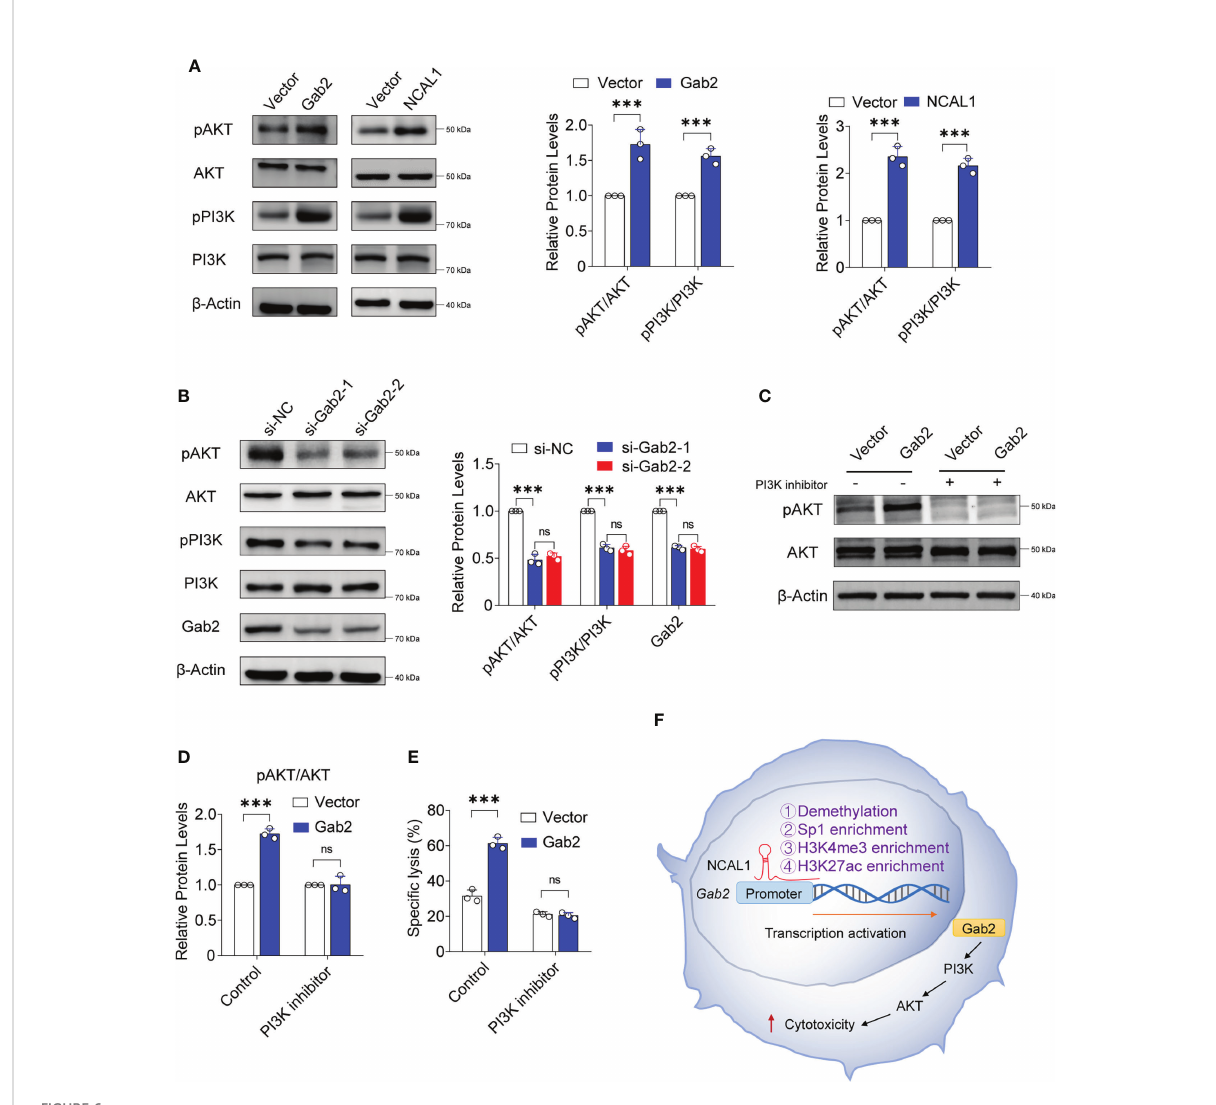
FIGURE 6 NCAL1 functions through the Gab2-PI3K-AKT axis. (A) NK92MI cells were transfected with Gab2 overexpression lentivirus, NCAL1 overexpression lentivirus, or control vector lentivirus. After GFP-positive cell selection, total protein extracts were obtained for immunoblotting. Representative western blots are shown in the left panel. The right panel shows the quanti fi cation of the bands from three independent experiments. Gab2: Gab2 overexpression; NCAL1: NCAL1 overexpression. (B) siRNA-mediated Gab2 knockdown in NCAL1-overexpressing NK92MI cells. Total protein extracts were obtained for immunoblotting. si-Gab2-1 and si-Gab2-2: siRNAs targeting Gab2; si-NC: random siRNA control. (C – E) NK92MI cells were transfected with Gab2 overexpression lentivirus or control vector lentivirus. After GFP-positive cell selection, the cells were treated with a PI3K inhibitor for 24 h. Total protein extracts were obtained for immunoblotting. (C) Representative western blots. (D) Quanti fi cation of the bands from three independent experiments. (E) Cytotoxicity was detected via calcein-release assays. Data represent three independent experiments. ns: not signi fi cant; *** p < 0.001, two-way ANOVA. (F) A proposed model describing how NCAL1 enhances the cytotoxicity of NK